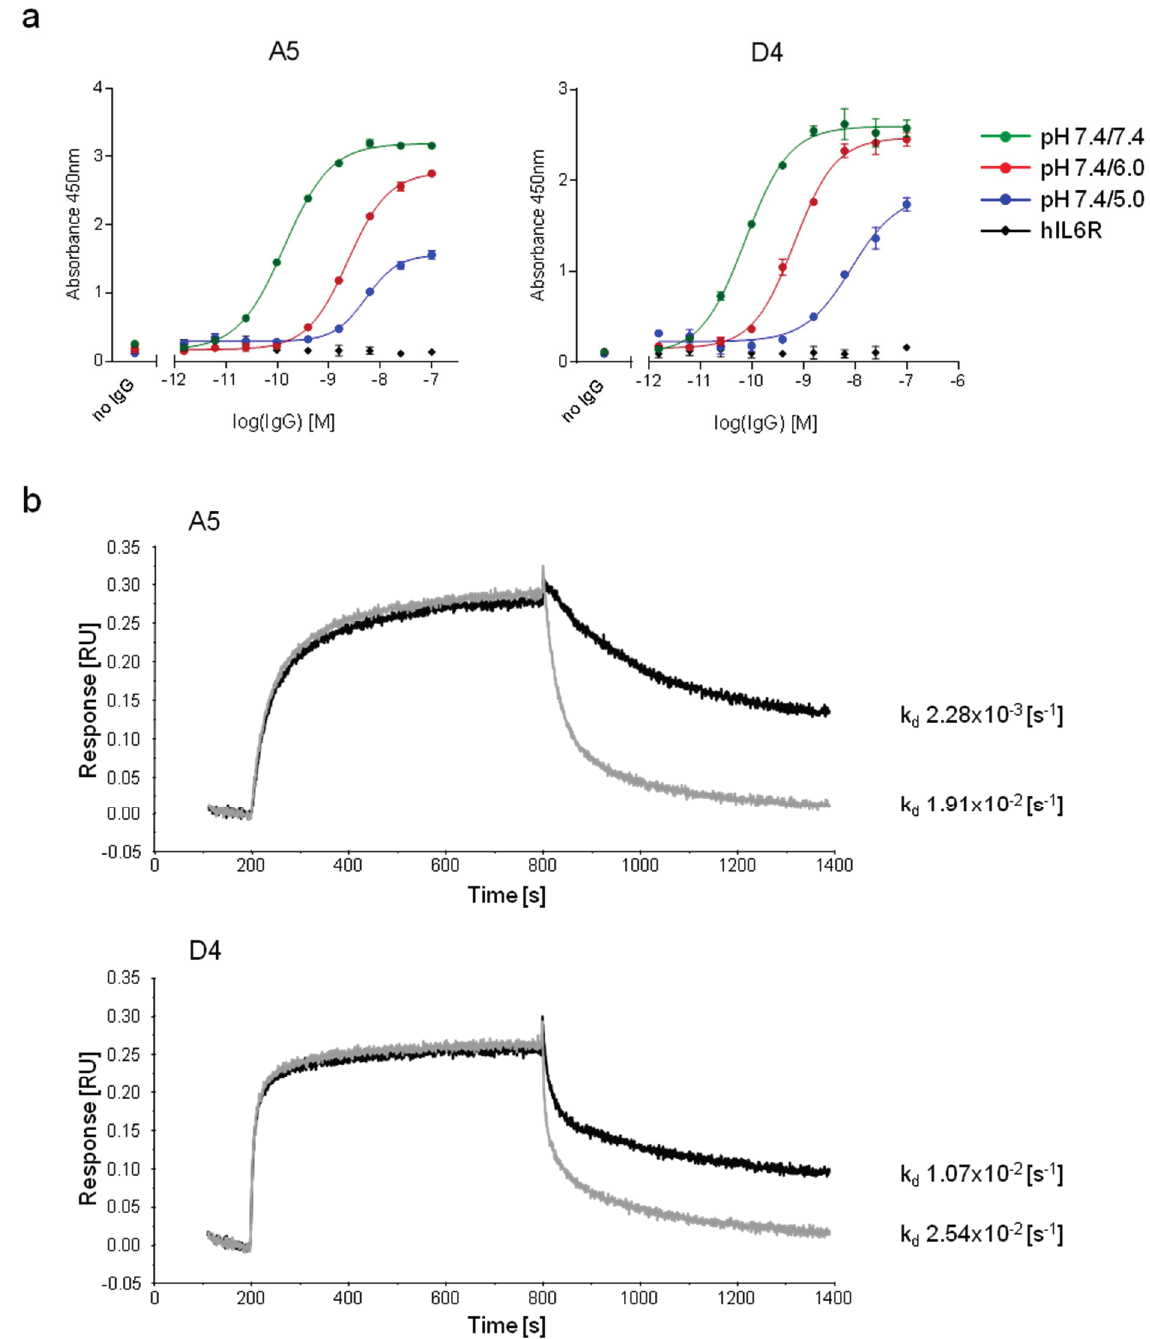
Figure 5. Characterization of the pH-dependent mIgGs, A5 and D4. ( a ) A pH-dependent ELISA was performed against hIgG1 using serial dilutions of A5 and D4 reformatted onto the mIgG1 backbone. The elution step occurred either at pH 7.4, 6.0 or 5.0. The binding to an irrelevant protein (hIL6R) was assessed to evaluate non-specific binding. Data are presented as the mean of duplicates ± SEM. ( b ) Bio-layer interferometry was performed using mIgGs. Antibodies were captured on murine specific biosensors and transferred to hIgG1-containing wells. The association (pH 7.2) and the dissociation (pH 7.2, black or 6.0, grey) were followed for ten